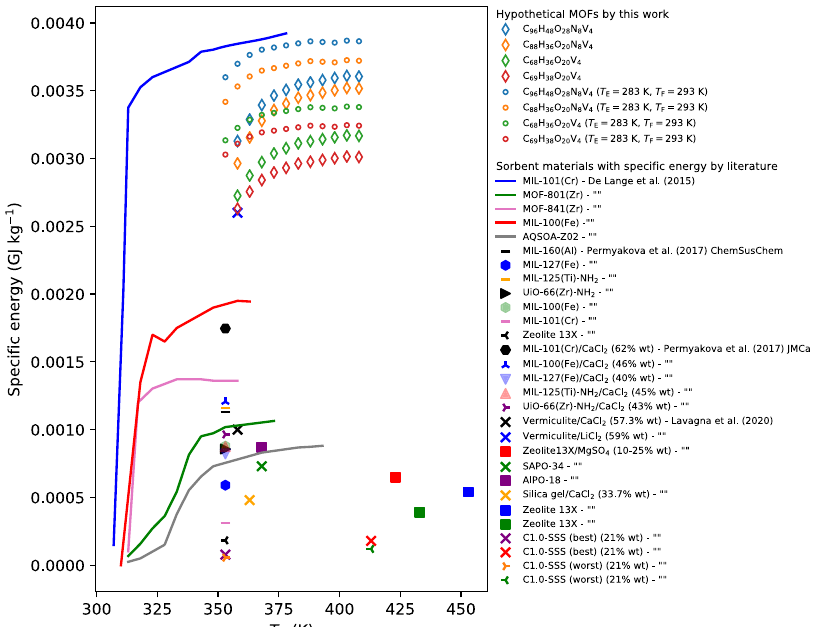
Fig. 8 Comparison between the expected speci fi c energy for several materials. Speci fi c energies are shown for different desorption temperatures T C both for the optimum MOFs identi fi ed in this work (either standard environmental conditions, i.e., evaporation temperature T E = 278 K and condensation temperature T F = 303 K, or with conditions of T E = 283 K and T F = 293 K, adsorption temperature T A = 308 K always) and for several water-sorbent materials in the literature 6,64,86,87